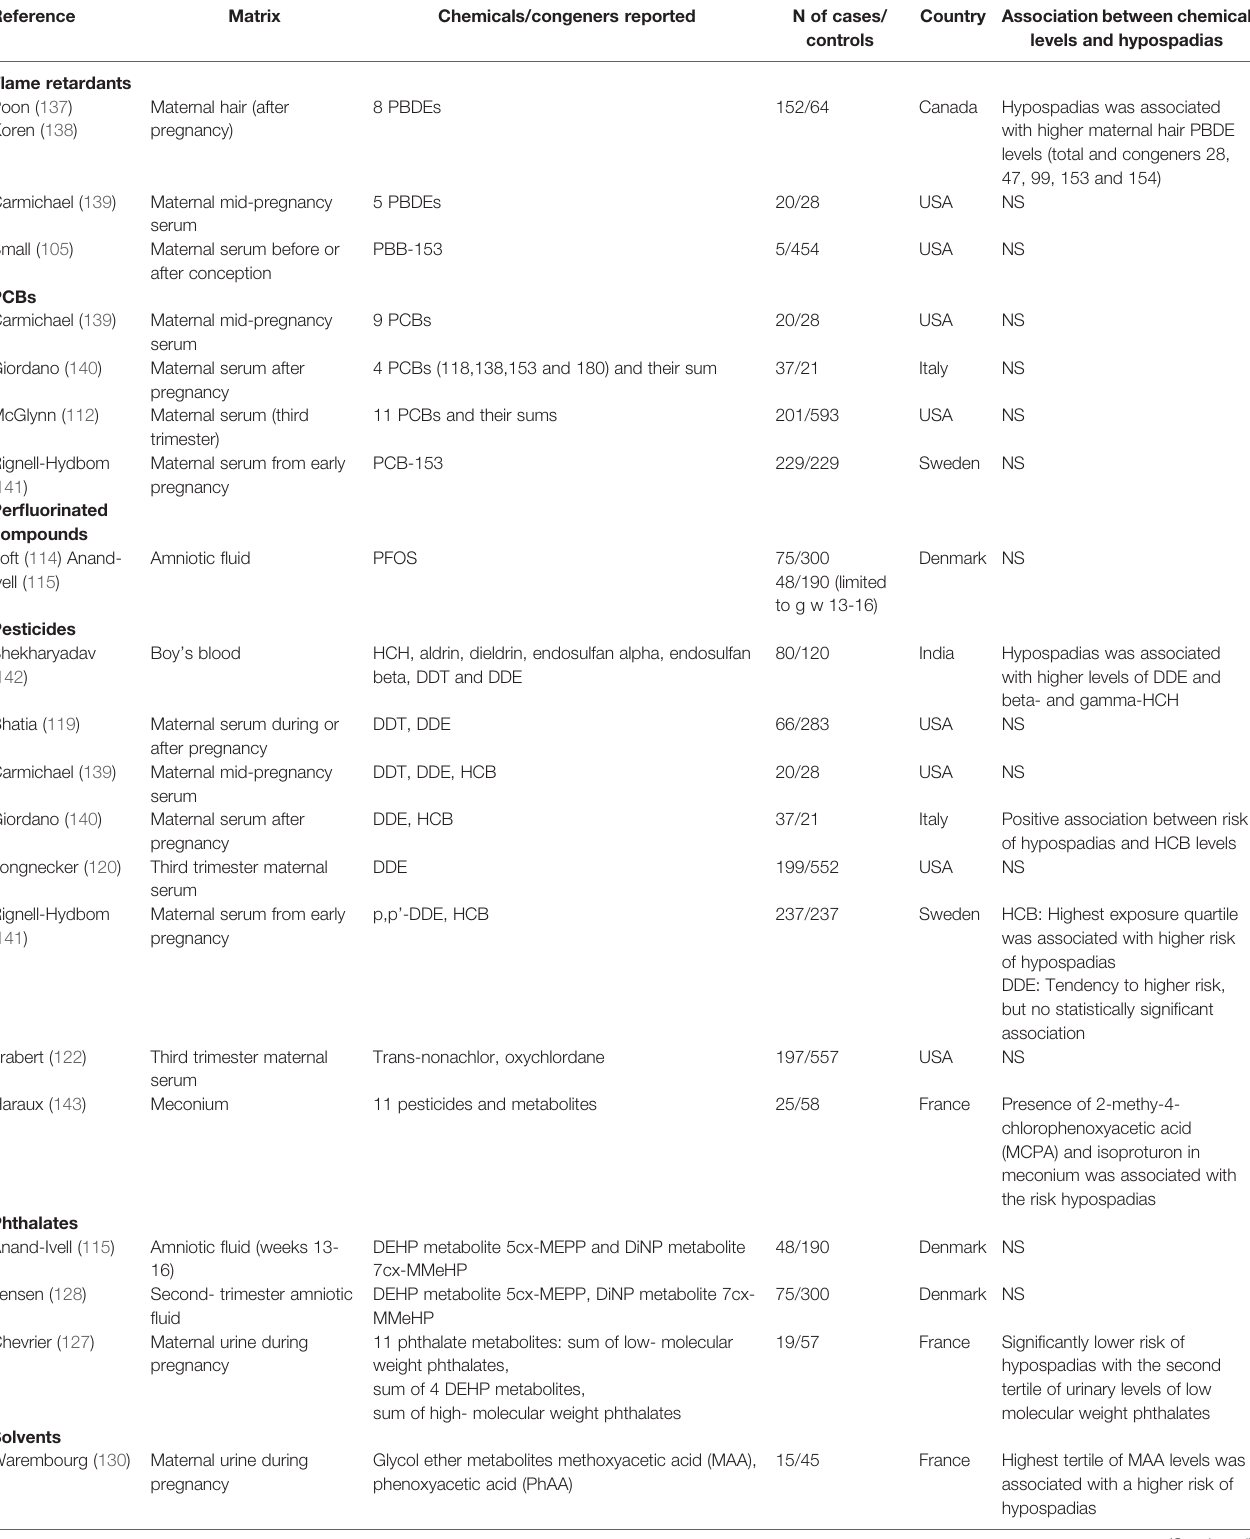
TABLE 3 | Case-control studies on the association between exposure to different classes of environmental EDCs (based on matrix measurements) and hypospadias in boys.